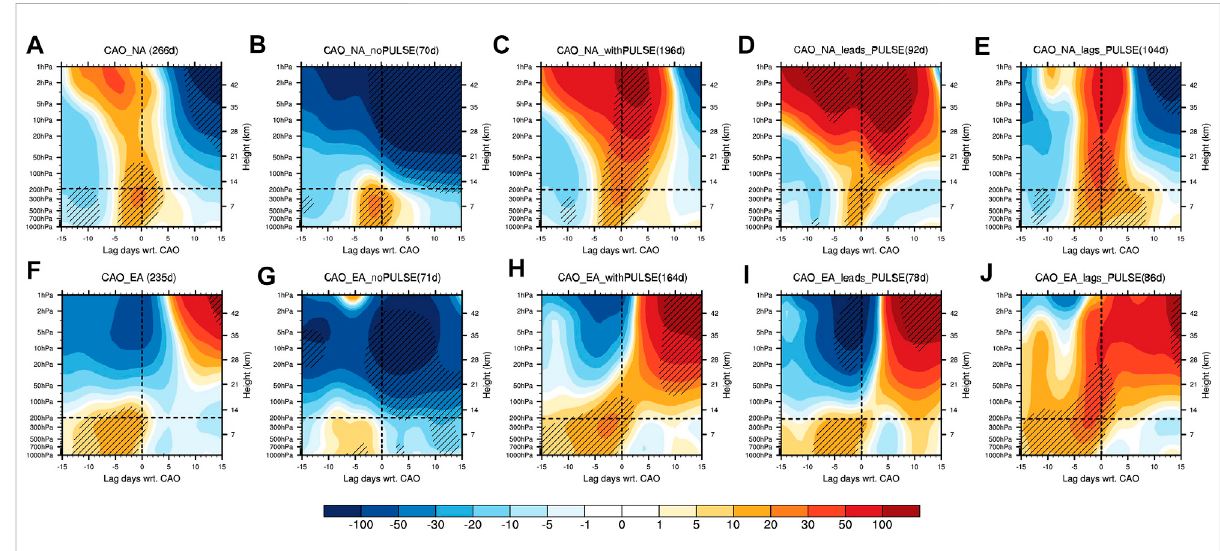
FIGURE 6 AsinFigure5,butforthegeopotentialheightanomaliesaveragedoverthepolarcap(60 ° − 90 ° N)atvariousisobariclevels.Thehorizontaldashed line roughly marks the tropopause level, which is 150 – 200